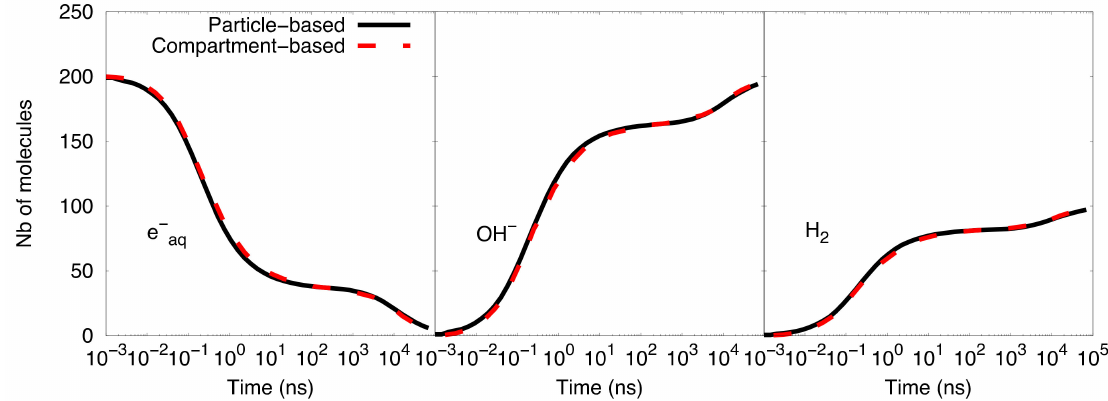
Figure 2. Compartment-based model for the simplified diffusion-reaction system compared with the particle-based SBS simulation.